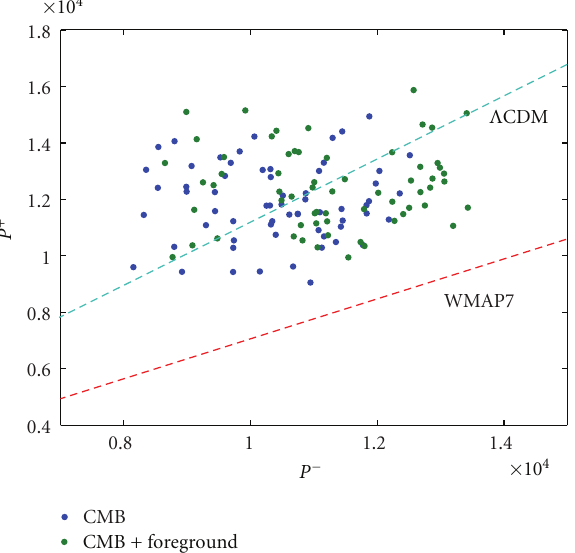
Figure 6: The power spectra of the templates (synchrotron, H α , dust): plotted with arbitrary normalization.